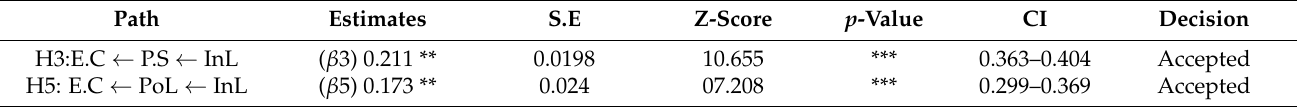
Table 6. Mediation and conditional